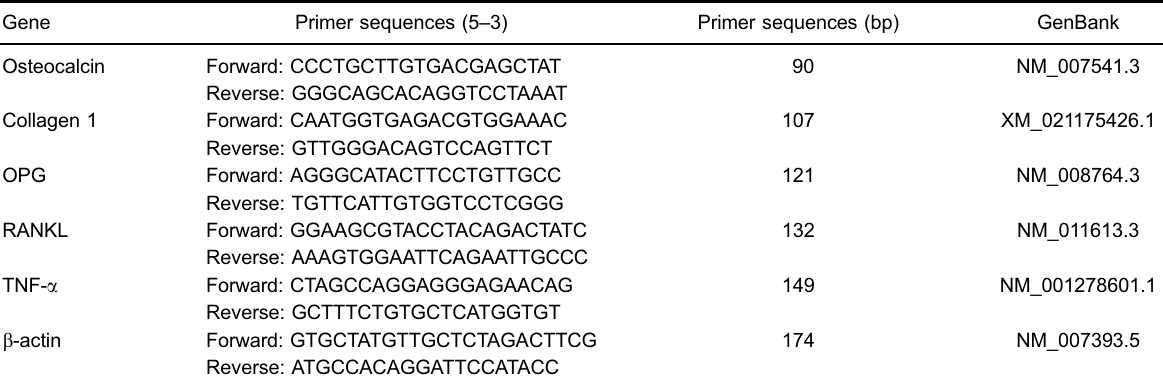
Table 1. Primers used for real-time reverse transcript-polymerase chain